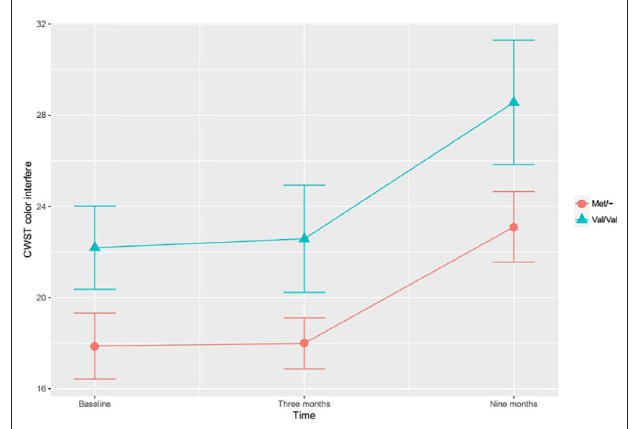
FIGURE 1 | The effects of brain-derived neurotrophic factor (BDNF) polymorphism on inhibition. Met/- carriers performed better than Val/Val carriers on the CWST color interfere task across all time points, F ( 1,97 ) = 5.417, p = 0.022. Note: CWST, Color-Word Stroop test. The error bars represent standard errors.